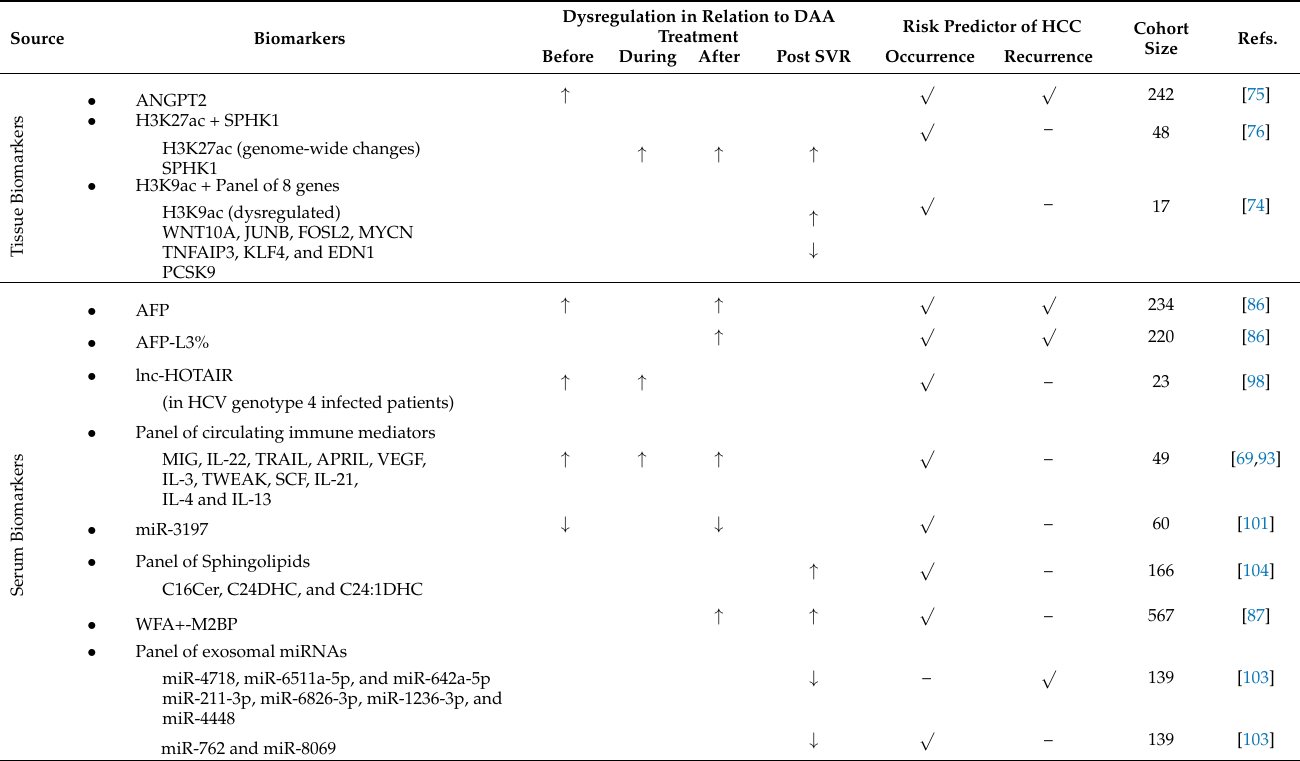
Table 4. Biomarkers in predicting HCC occurrence and recurrence in DAA-treated